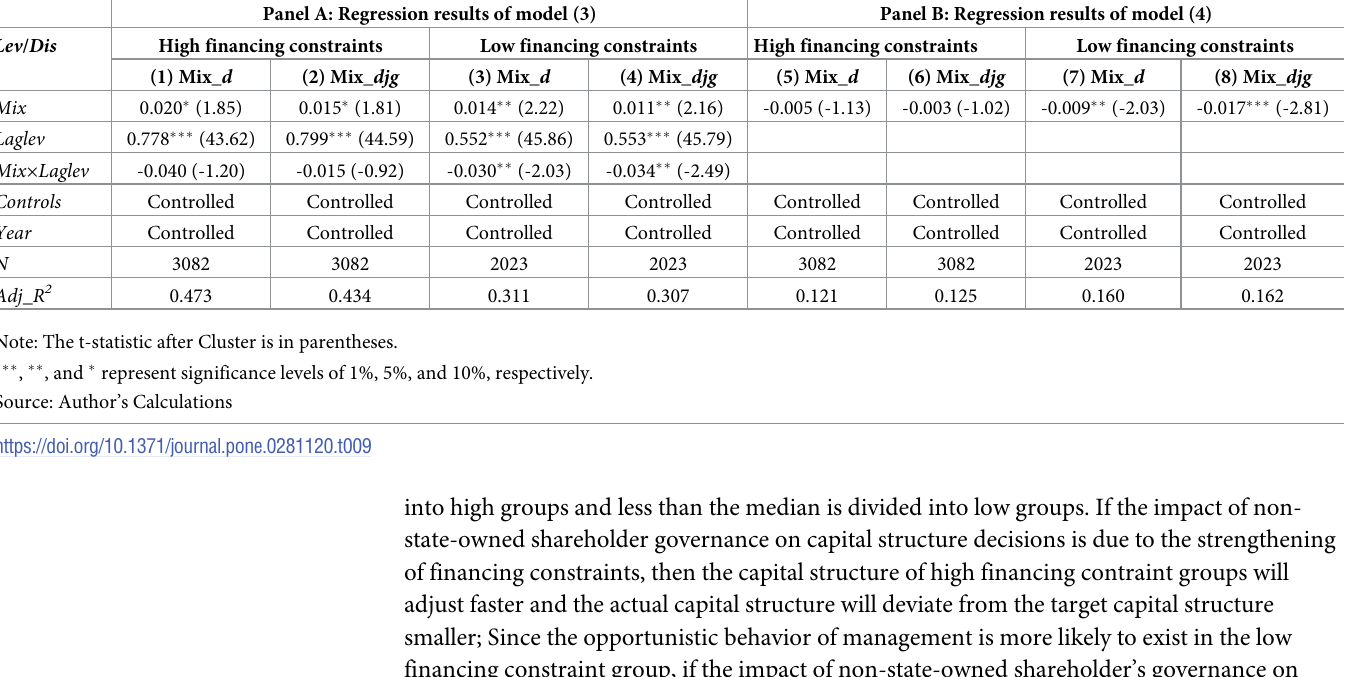
Table 9. Non-state-owned shareholders governance and decision-making on capital structure under different financing constraints. Panel A: Regression results of model